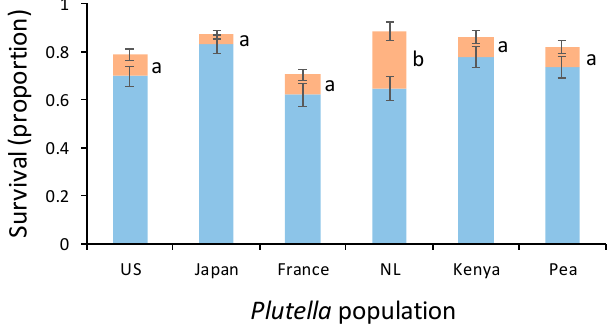
than the Pea moths.